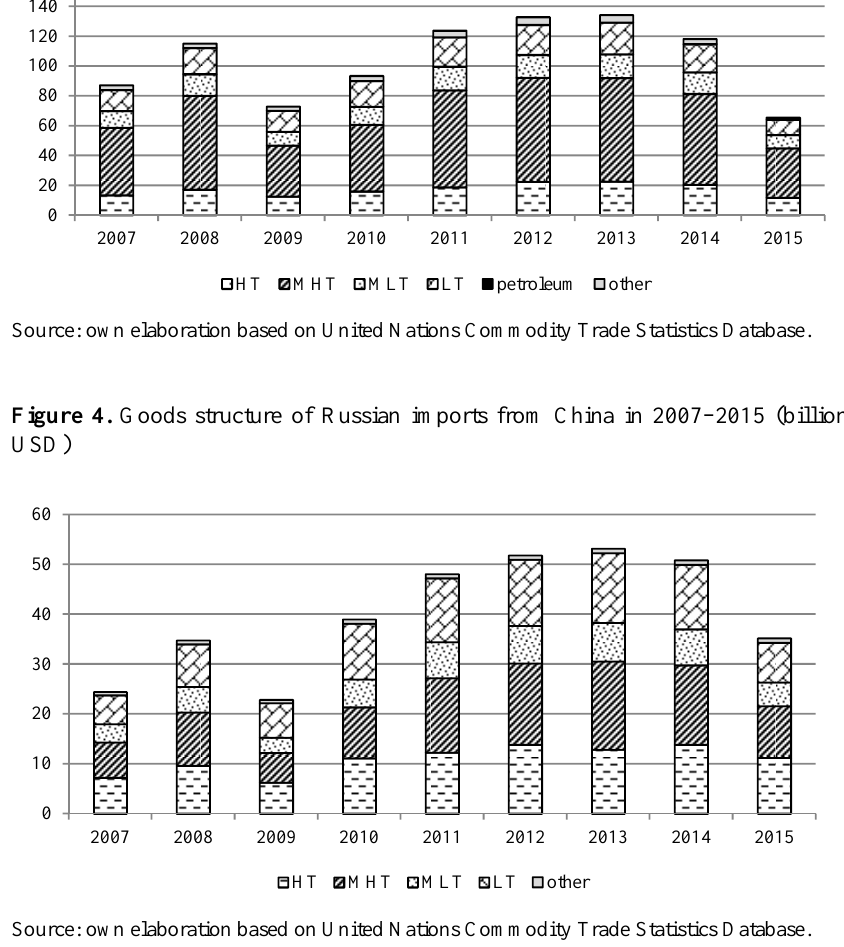
Source: own elaboration based on United Nations Commodity Trade Statistics